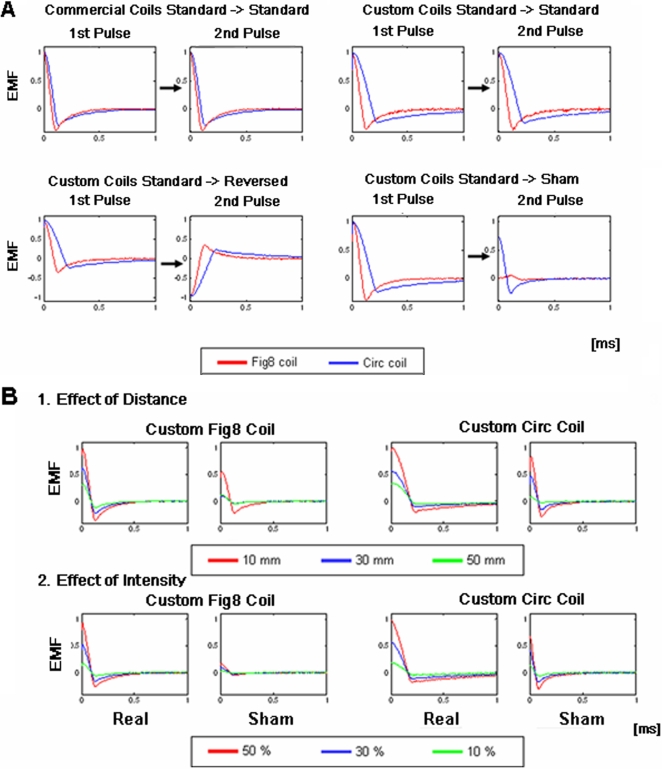
Electromagnetic force (EMF) measurements of Standard, Reversed and Sham TMS with Fig8 and Circ coils.(A) Effects of 1st pulse on 2nd pulse. Two consecutive pulses were delivered at 10 ms interstimulus interval (ISI) at 50% maximum output and EMF was measured. All EMF values are normalized to the 1st pulse. (B) Effects of distance, intensity and position. B-1. EMF measured at varying distances between custom Fig8 or Circ coils and search coil. Values are normalized to those of Standard TMS at 10 mm. B-2. EMF measured at varying TMS intensity with custom Fig8 and Circ coils. Values are normalized to those of Standard TMS at 50% maximal output. For clarity, all plots show data for Reversed pulses as inverted and collapsed with data for Standard pulses, as they showed no significant differences beside their polarities.